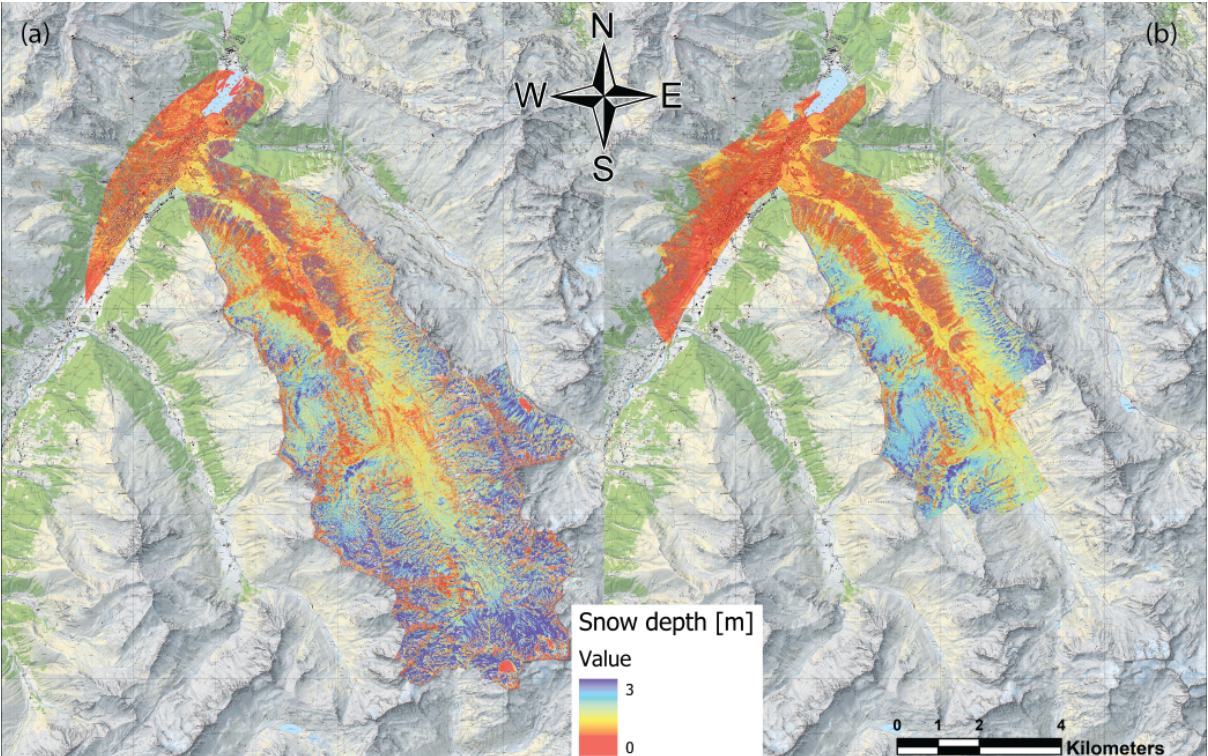
Figure 10. Snow depth maps of the satellite (a) and the airplane (b) platforms for the whole Dischma valley. The snow depth ranges from 0m (red) to 3m (blue) based on the summer ALS reference surface (Swiss Map Raster, source: Federal Office of Topography; Pléiades data © CNES 2018, Distribution Airbus DS).